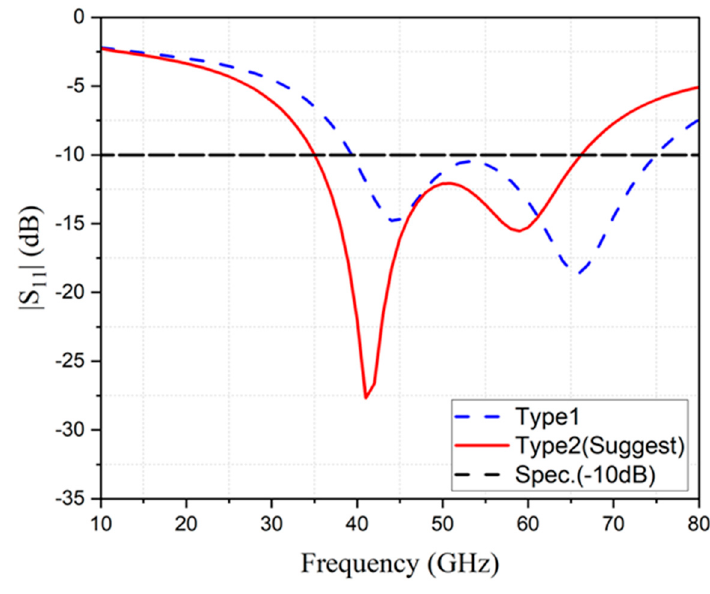
Figure 13. Reflection coefficients (S11) of different periodic array sizes of AMC.